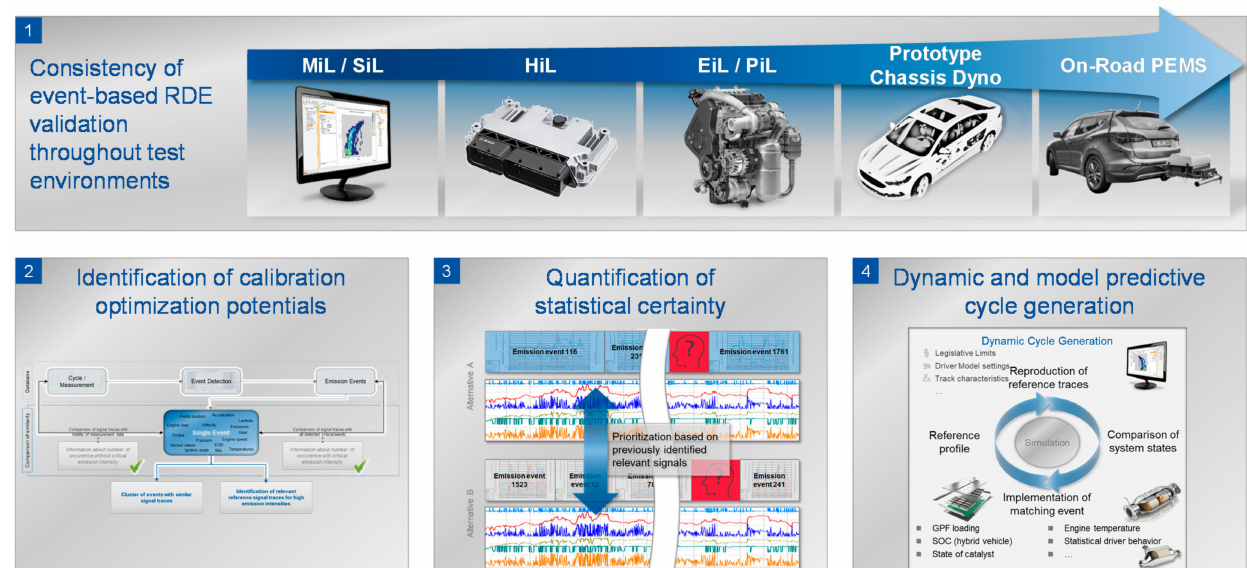
Figure 2. Criteria for the conception of the novel methodology for virtual calibration.